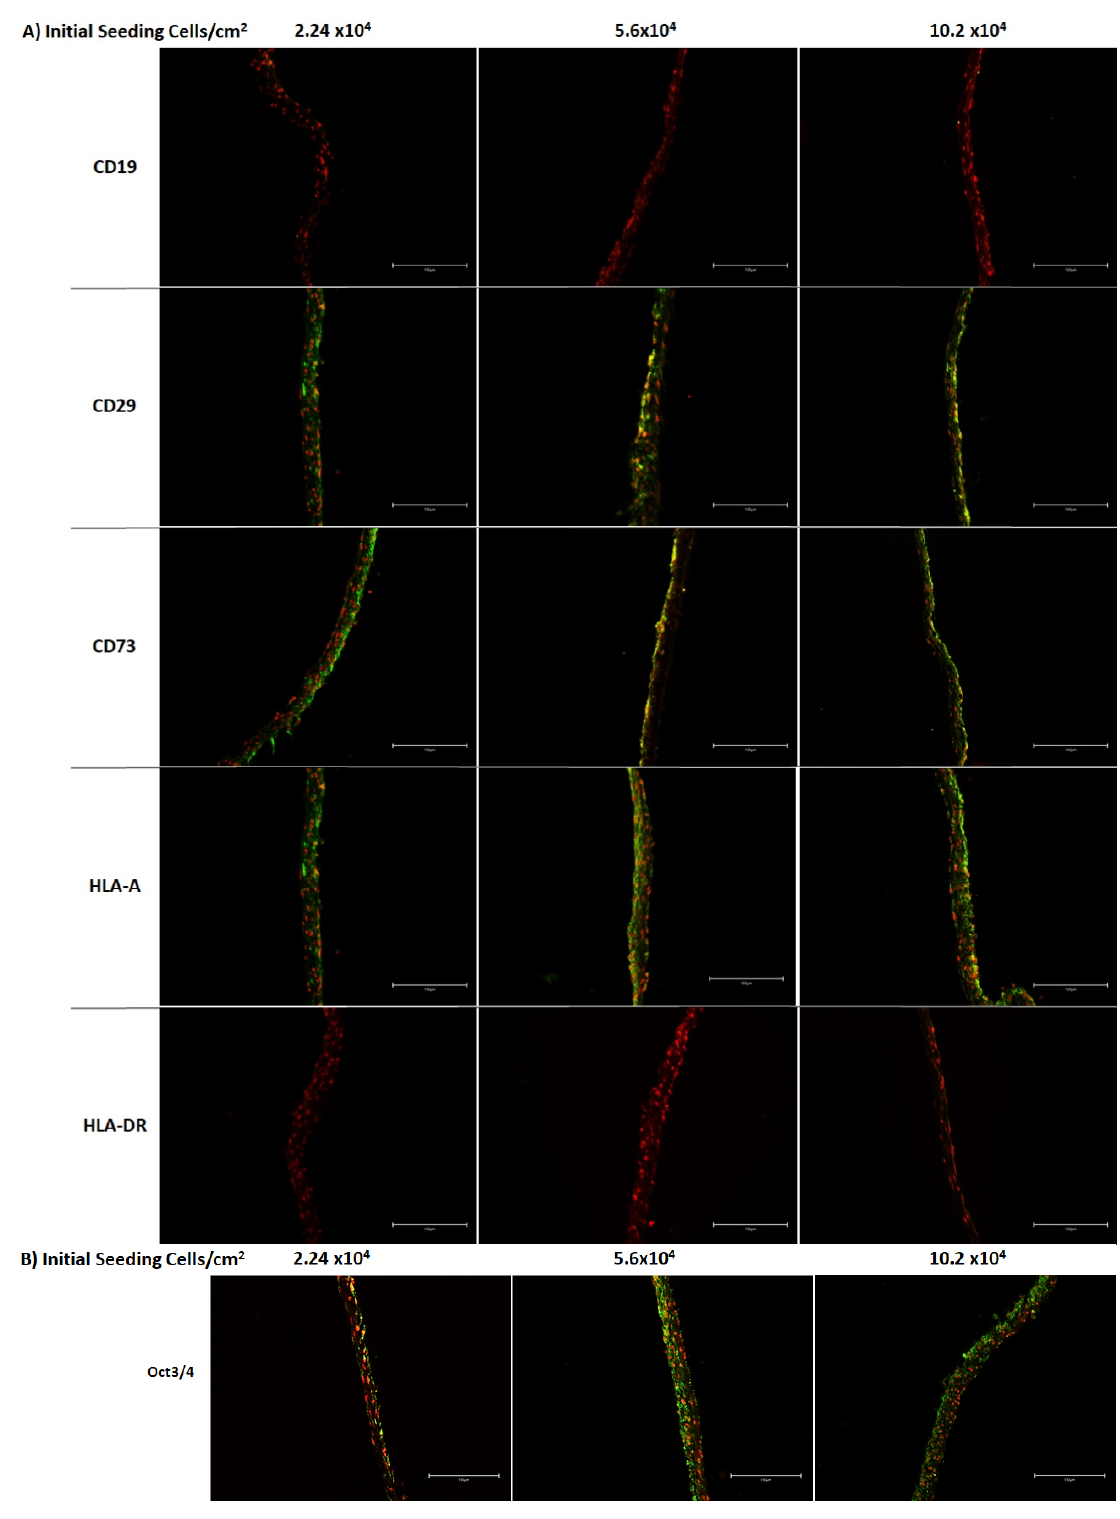
Figure 4. ( A ) Immunostaining on CD19, CD29, CD73, HLA-A, and HLA-DR was performed on the undifferentiated cell sheets harvested at 12 days, initially seeded with 2.24 × 10 4 , 5.6 × 10 4 , 10.2 × 10 4 ASC per cm 2 (scale bar 150 μ m). ( B ) Immunostaining on 3/4 October was performed on the undifferentiated cell sheets harvested at 12 days, initially seeded with 2.24 × 10 4 , 5.6 × 10 4 , 10.2 × 10 4 ASC per cm 2 (scale bar are 150 μ m). The expression of mRNA of CD14, CD29, CD31, CD44, CD73, CD90, CD105, CD166, HLA-A, and HLA-DR were analyzed at 12 days. In Figure 5, isolated ASC express the